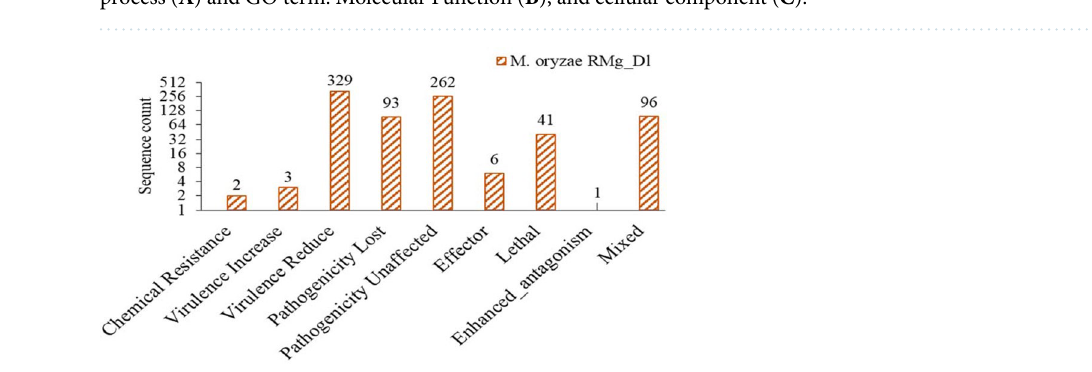
Figure 4. Functional annotation of predicted genes/proteins of M. oryzae RMg_Dl in GO term: biological process ( A ) and GO term: Molecular Function ( B ), and cellular component ( C ).